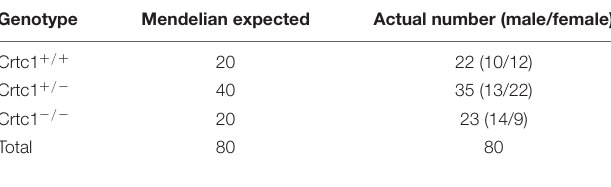
TABLE 1 | Information on offspring mice of heterozygous Crtc1 + / − mice mating. Genotype